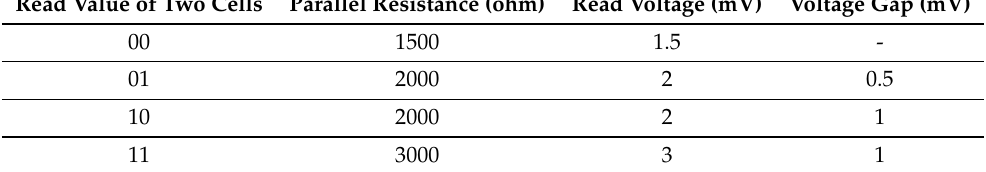
Figure 1. SOT-MRAM circuit for CIM [8]. ( a ) depicts an improved circuit with lower read and write current; the circuit is also more robust when executing CIM operations. ( b ) presents a conventional circuit that requires a larger current for reading and writing when performing CIM operations to achieve the same robustness as the improved circuit. Table 2. Read results for the circuit in Figure 1b (1: R AP = 6000 (ohm), 0: R P = 3000, input current 1 µA). Read Value of Two